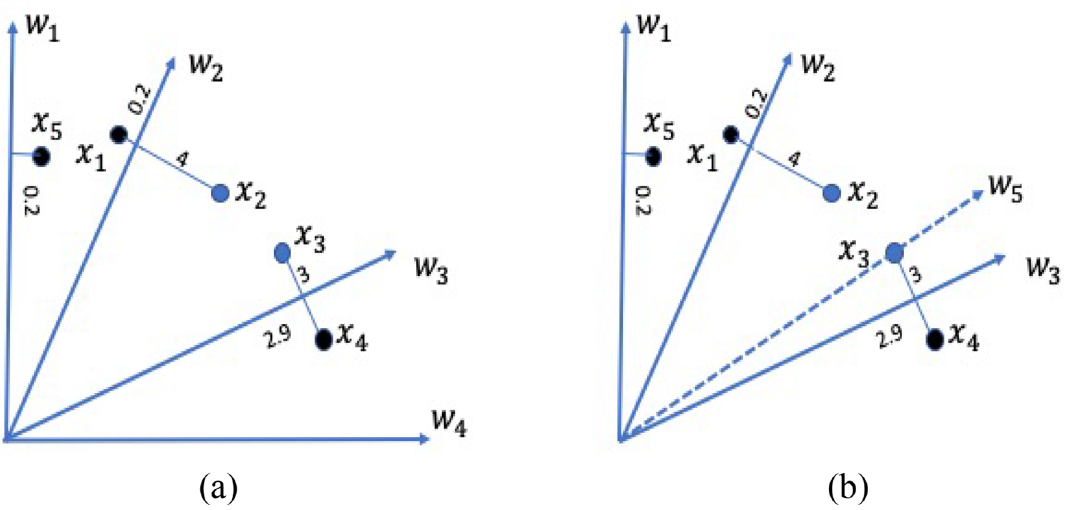
Figure 1. Selection of